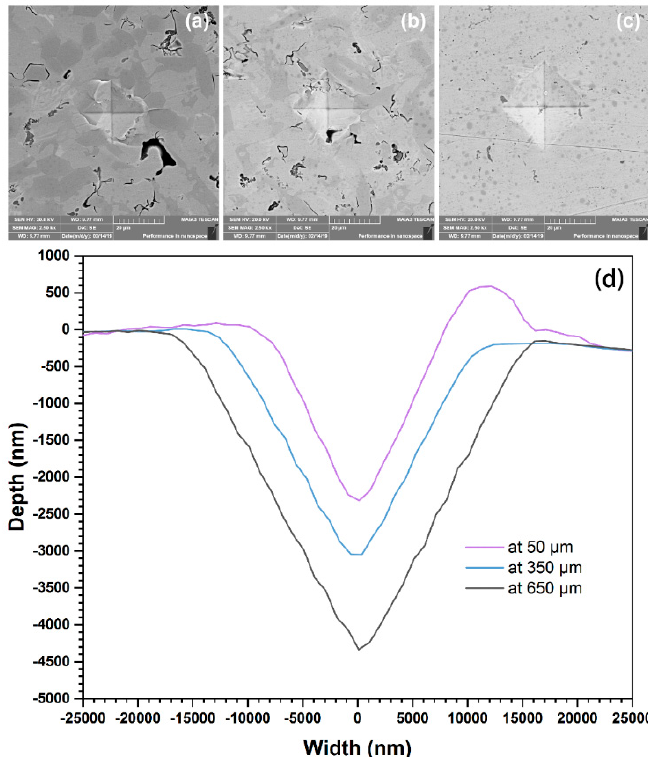
Figure 10. Indentation morphology of different depths from edge ( a ) 50 µ m, ( b ) 350 µ m, ( c ) 650 µ m, and ( d ) indent profile of the FeCoCrNiMo HEA after sintering at 1150 °C and 30 MPa.